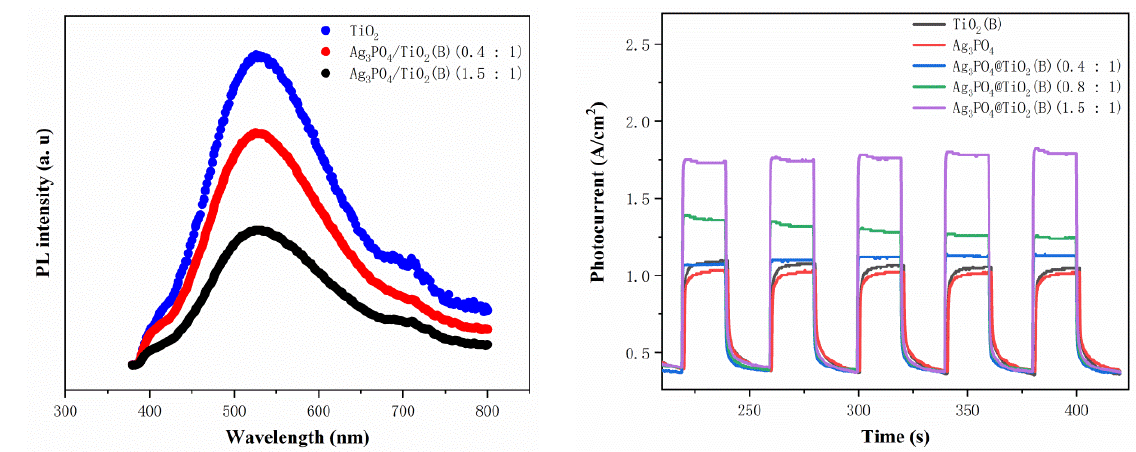
Figure 7. PL and photocurrent spectra of synthesized samples.